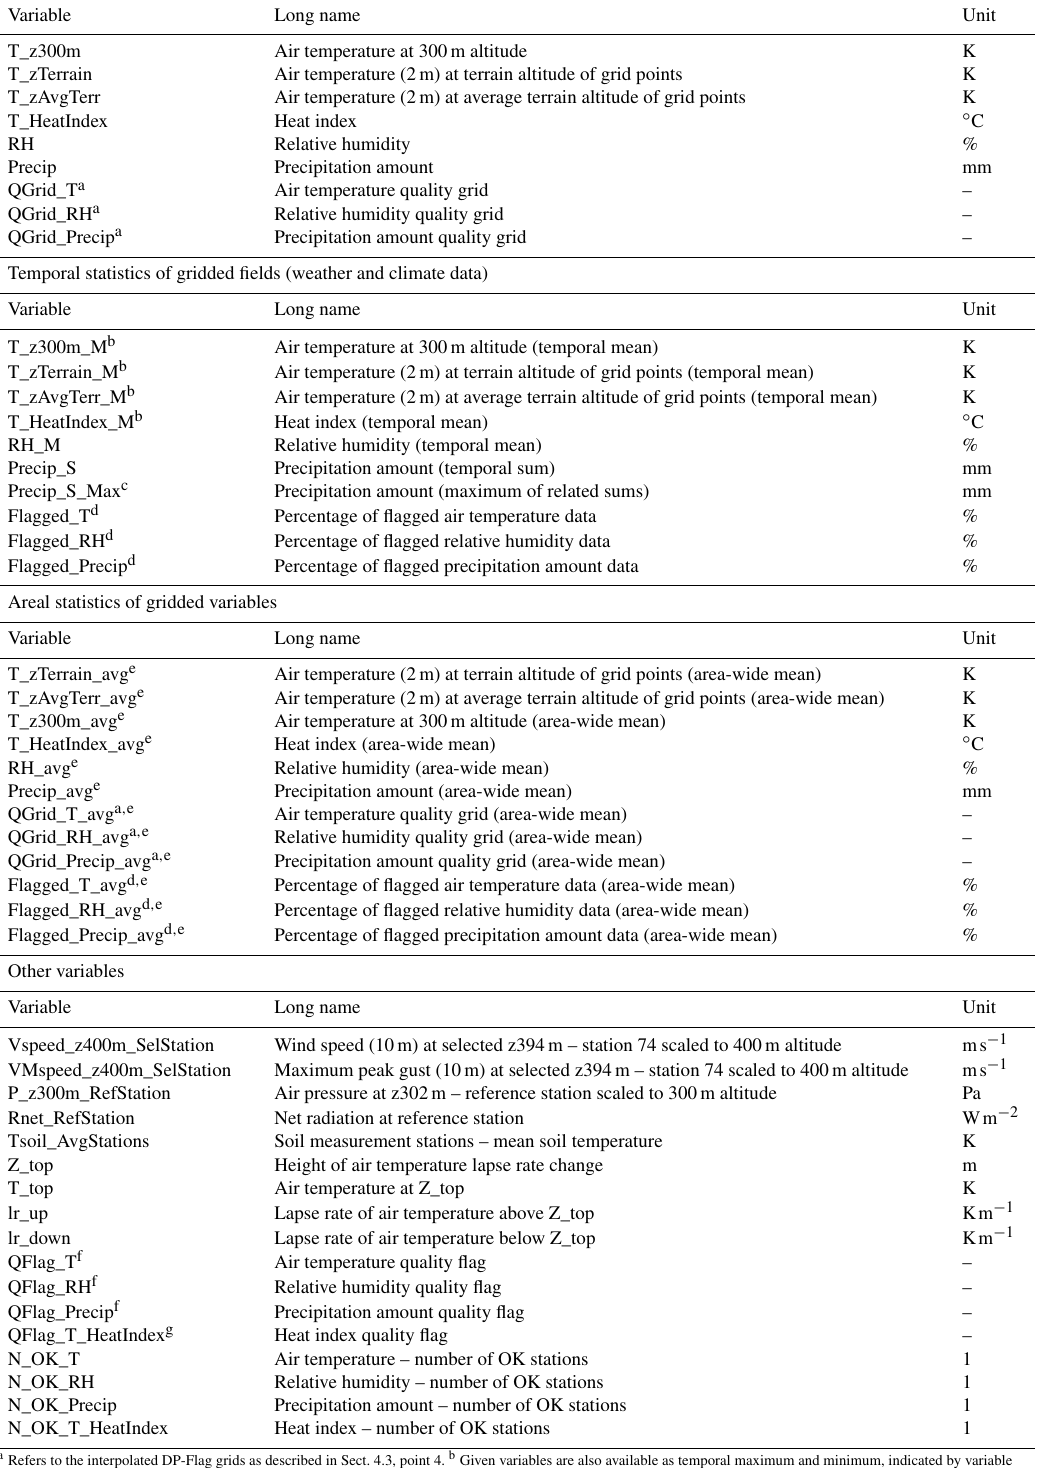
Table A3. List of variables of WegenerNet level 2 and 2+ NetCDF data. Gridded basis data